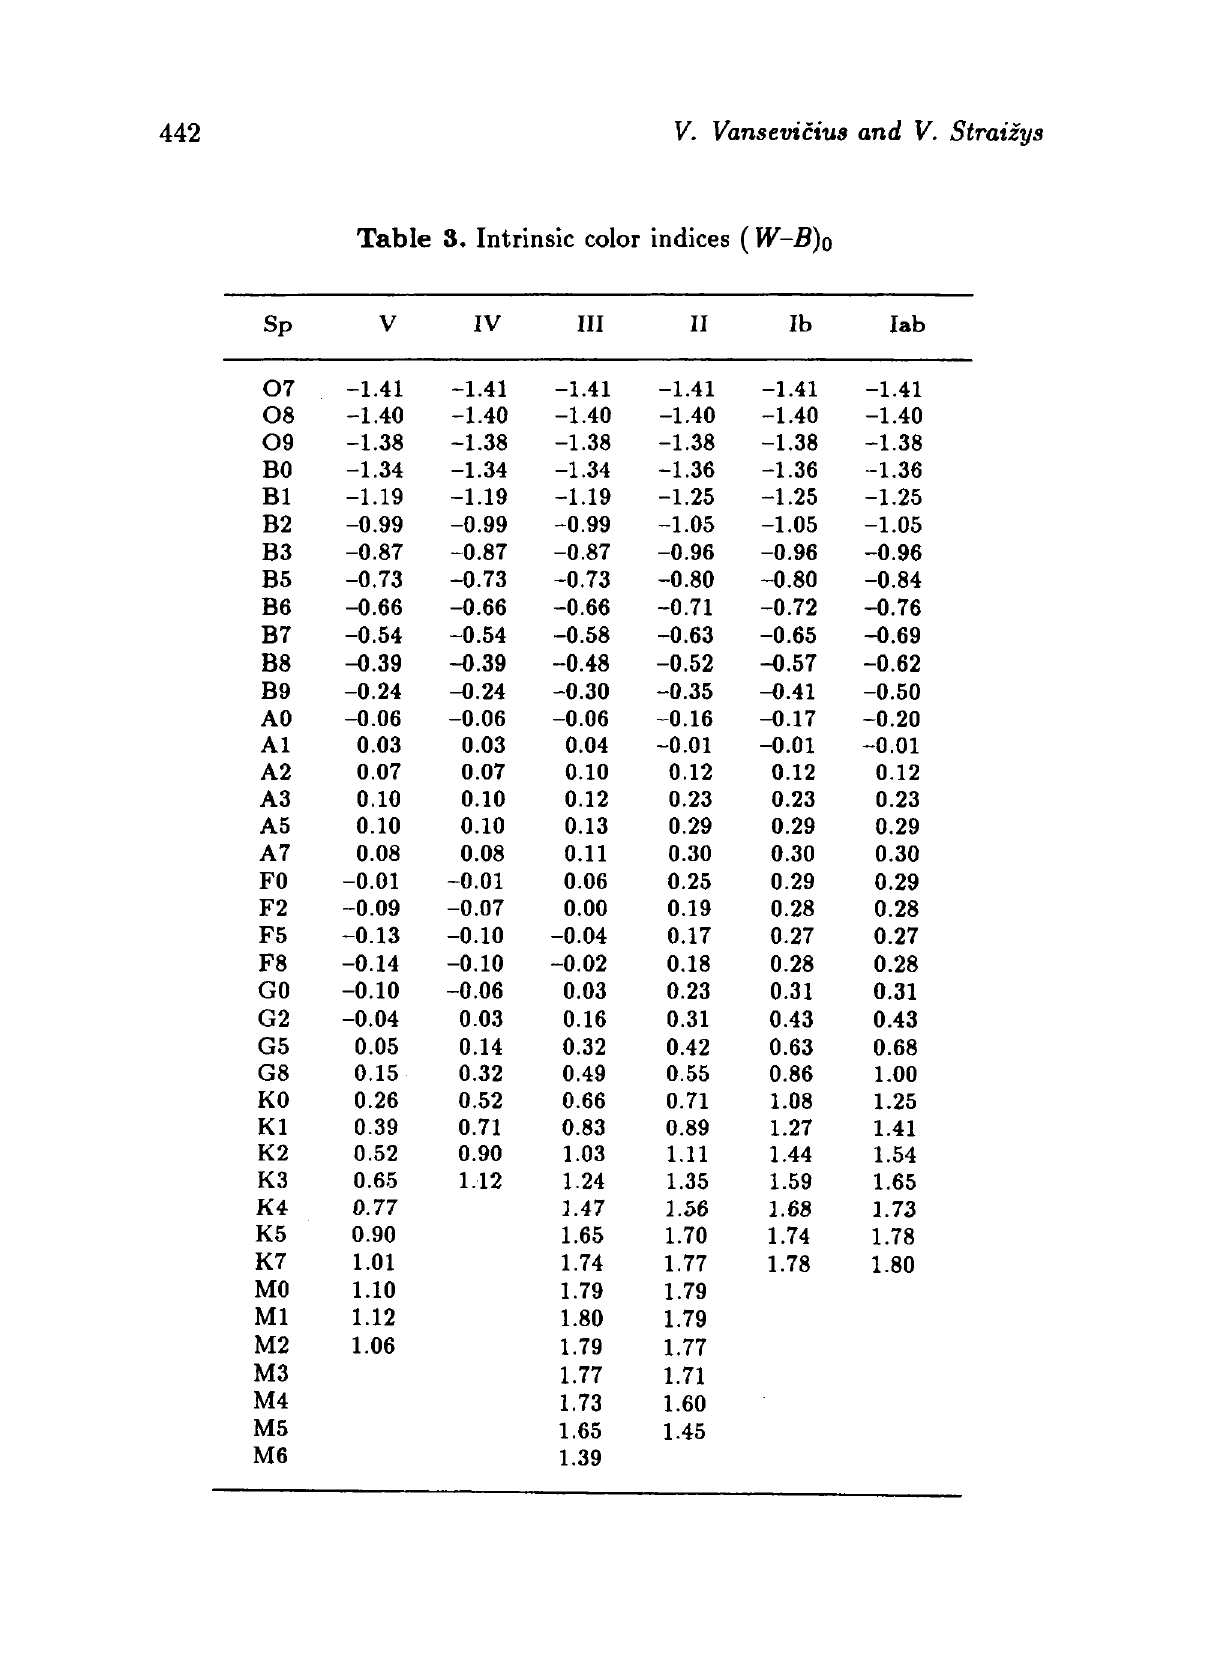
Table 3. Intrinsic color indices ( W-B)